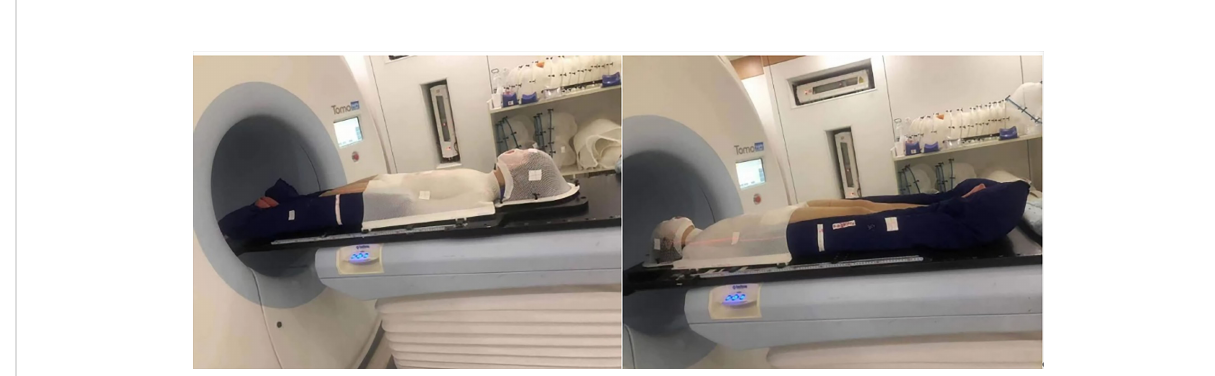
FIGURE 3 The upper section head advanced mode and the lower foot advanced